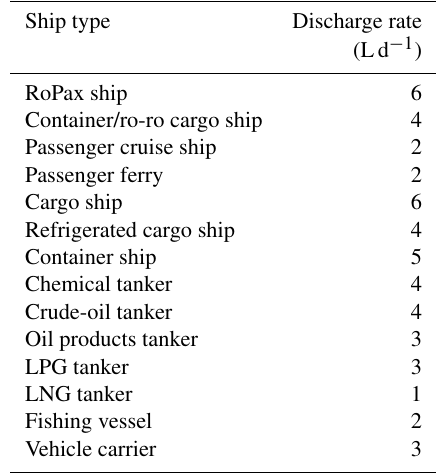
Table 1. Leakage rates of stern tube oil for different ship types. The data was gathered from Etkin